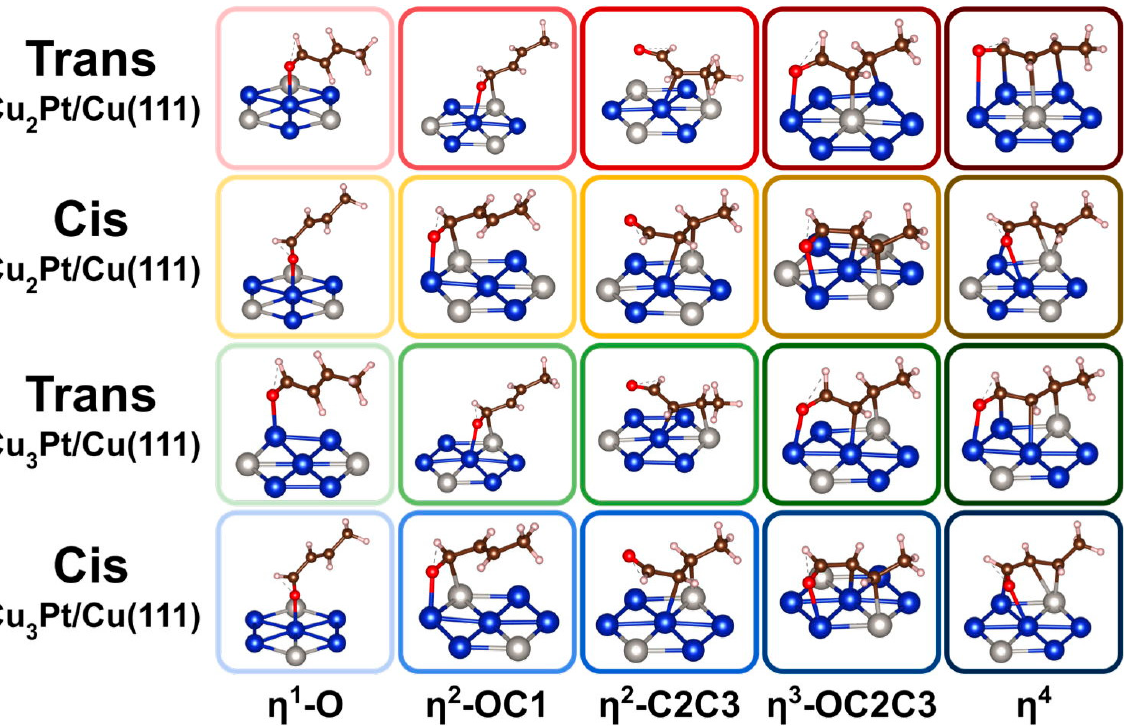
Figure 2. Optimized structures calculated for the cis and trans configurations of crotonaldehyde adsorbed on Cu 2 Pt/Cu(111) and Cu 3 Pt(111) surfaces, as a function of coordination mode. Atom color code: blue = Cu, grey = Pt, red = O, brown = C, and white (small) = H.